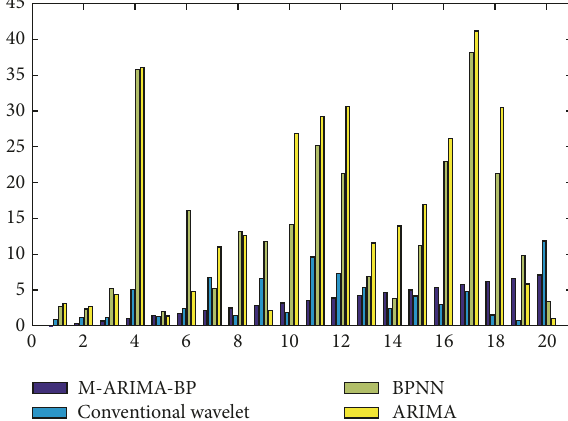
Figure 11: Absolute error of single point prediction of Shanghai Stock